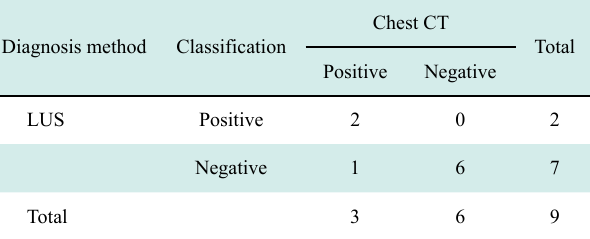
Table 2 Results of LUS and chest CT in the diagnosis of COVID-19 Diagnosis